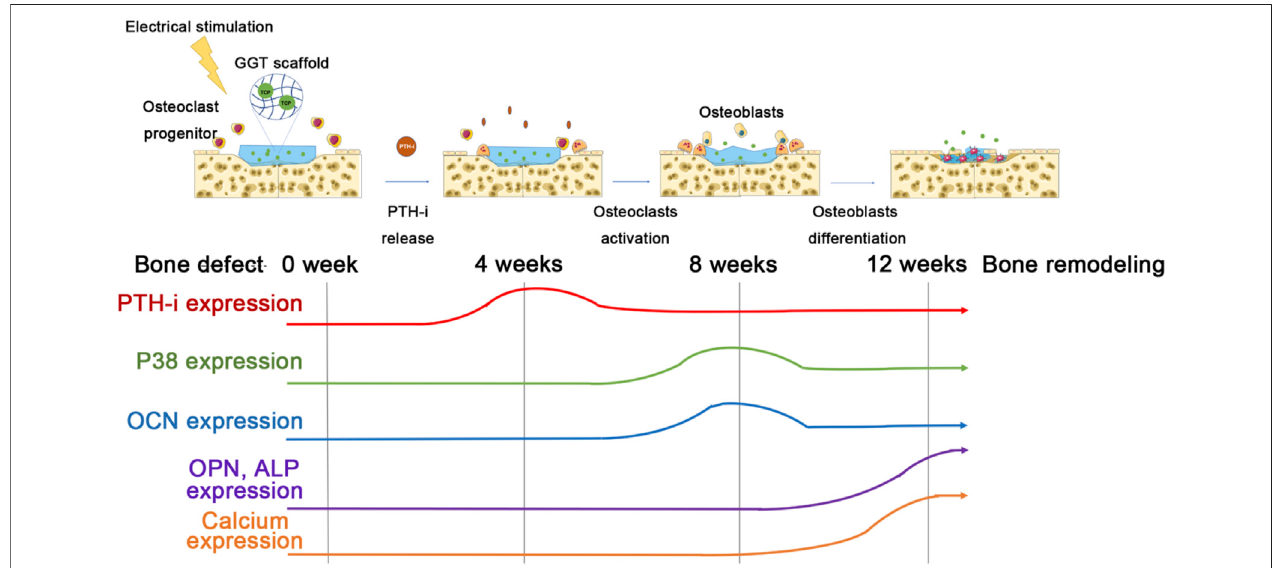
FIGURE5| Schematic fi gureofthepossiblemechanismoftheeffectofelectroacupunctureontheregulationofPTH-i,calcium,osteoclasts,andosteoblastsinthe bone-defected rats.